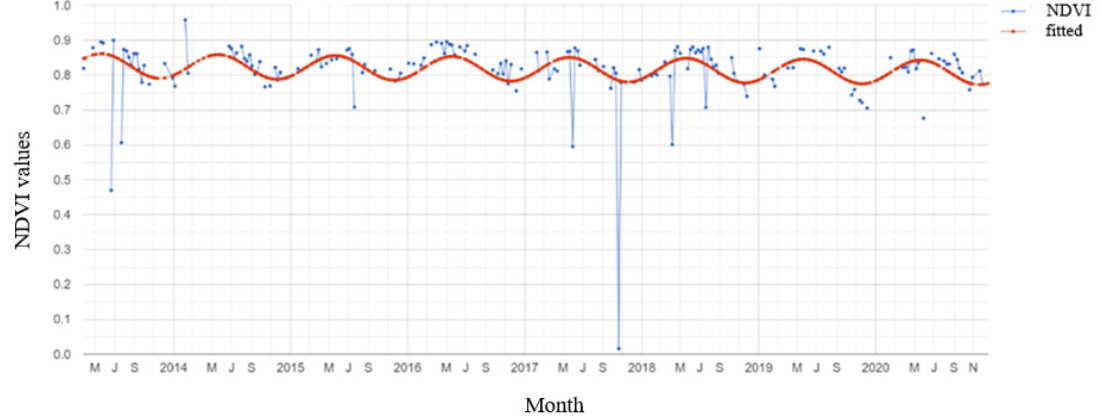
Figure 4. Harmonic regression model original and fitted values of all available (2012–2020) Landsat 8 imagery with mangrove NDVI. The red line is the fitted NDVI values and the blue dotted line is the original NDVI values for mangrove forest in the mid-section of our study region. The site is located directly adjacent to Koumala Station, Figure 1, Bowen to Shoalwater and Corio Bays Area Ramsar Wetland, Central Queensland.